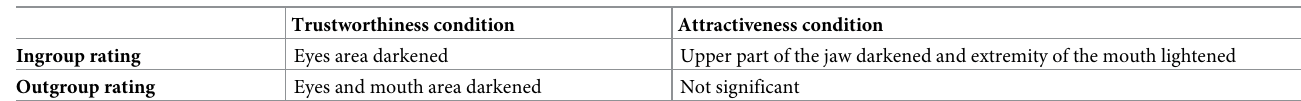
Table 1. Results